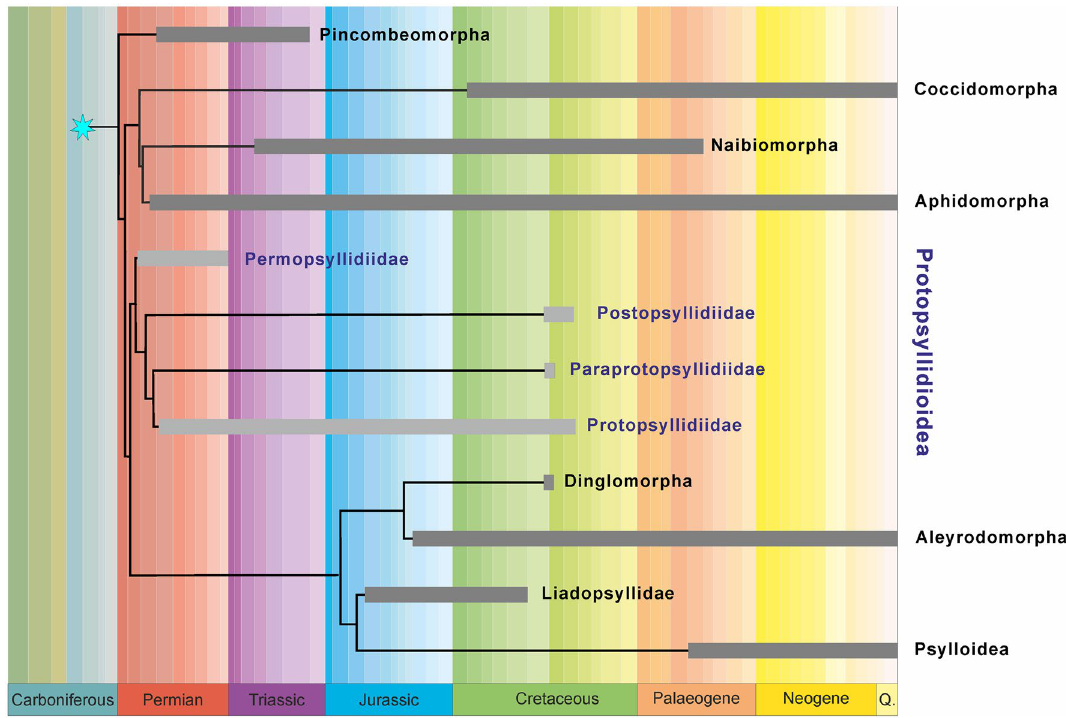
Figure 5. Tentative relationships of Protopsyllidioidea and other Sternorrhyncha (based on data and interpretations from Drohojowska et al. 14 and Hakim et al. 7 ; figure generated with use of CorelDraw